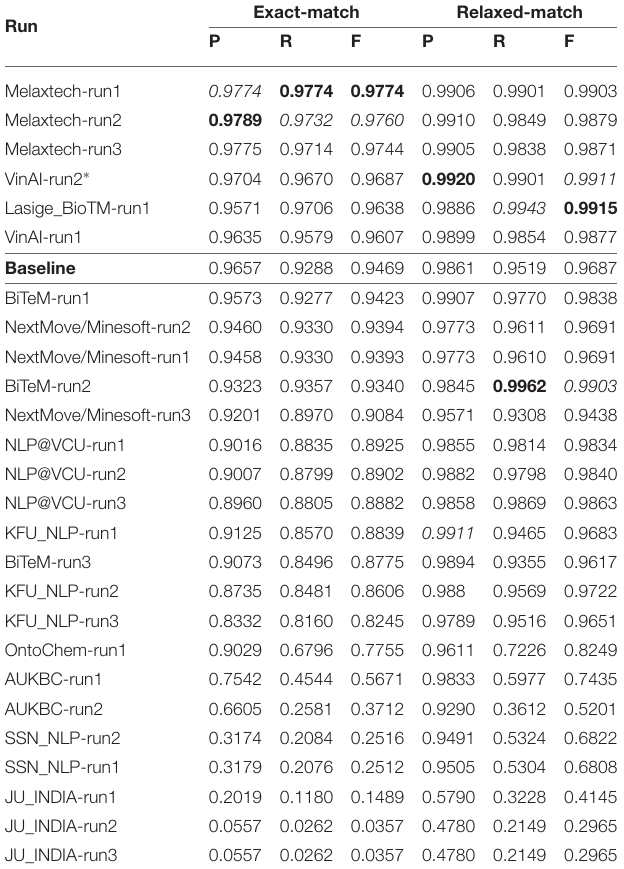
where the set of high-level labels in Figure 7 is used.